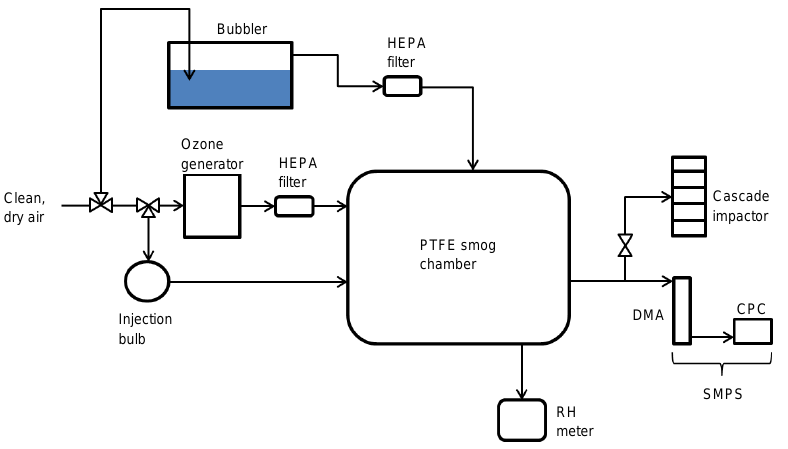
Figure 1. Experimental setup used to generate and collect oxidized α -pinene particles. The smog chamber is initially flushed with dry or wet air. Once the relative humidity in the chamber is established, particles are generated in the smog chamber by mixing α -pinene and ozone. Resulting particles are either analyzed with the SMPS or sampled using the cascade